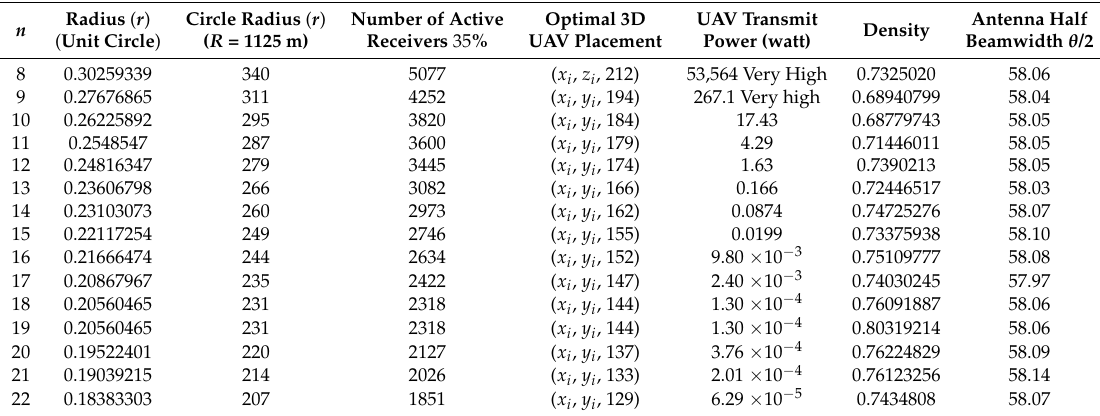
Table 6. Simulation results for packing n identical circles in a circle region with r = 1.125 km, ( x i , y i ) (cid:101) i = 1, . . ., n .